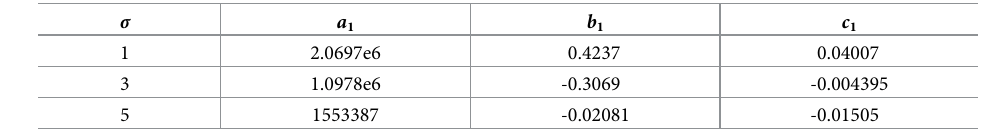
Table 7. Fitted parameters as in Eq (31). σ